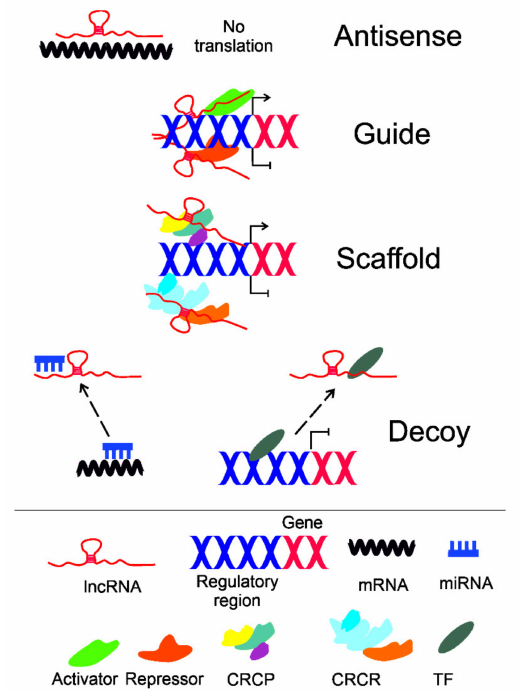
Figure 3. Basic modes of the cellular action of long non-coding RNA (lncRNA) in the regulation of gene expression: antisense, guide, scaffold, and decoy. A lncRNA may pair with a complementary fragment of mRNA, preventing or inhibiting its translation. A lncRNA recruits and/or guides transcriptional activators and repressors to activate/repress transcription of the target gene. A lncRNA may serve as a platform (scaffold) to facilitate assembling a chromatin remodeling complex to change the structure of chromatin into a more open (CRCP—chromatin remodeling complex acting permissively) or closed (CRCR—chromatin remodeling complex acting repressively) configuration. A lncRNA may act as a decoy to recruit (broken arrows) micro RNAs (miRNAs) or transcriptional factors (TFs) and sequester them from their target mRNA or DNA, respectively. Presented are only examples of lncRNAs actions in gene expression regulation, and many other mechanisms, e.g., those related to translation and post-translational regulations, are not illustrated, but in general, they follow the presented schemes. Some modes of action of lncRNAs may